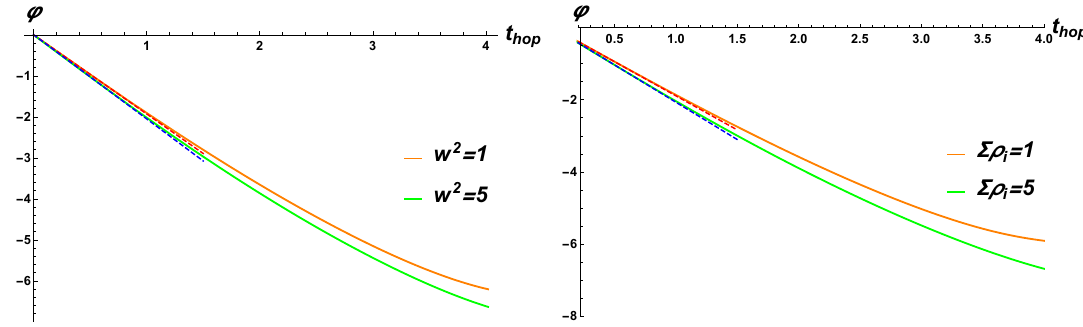
Figure 2 . The subleading term ’ as the function of t hop in the non-homogeneous phase with the Neumann boundary condition ((cid:3) = 1, u h = U = 40, and q = p 6 = 5). This term contributes to the total hopping kinetic energy in the super(cid:13)uid phase. Dashed lines mean analytic results (B.4) obtained in appendix B. Left: for (cid:21) = 1, and all (cid:3) ( p;r ) = 0. For small t hop , ’ is almost a linear function of t hop . Right: for (cid:21) = 1, w = 0, (cid:3) (1 ; 1) = 3 = 2 and other (cid:3) ( p;r ) = 0. ’ is a linear (cid:0)